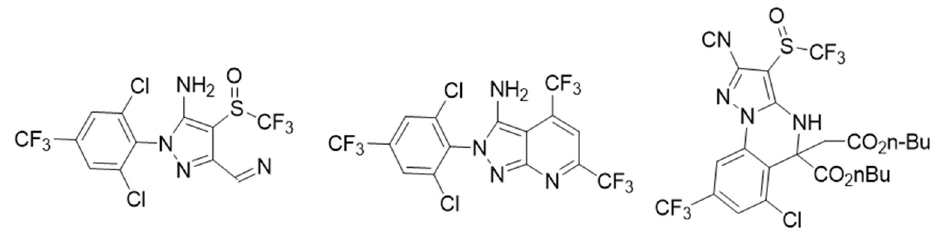
Figure 5. Heterocyclic compounds analogous to fipronil as GABA antagonists.